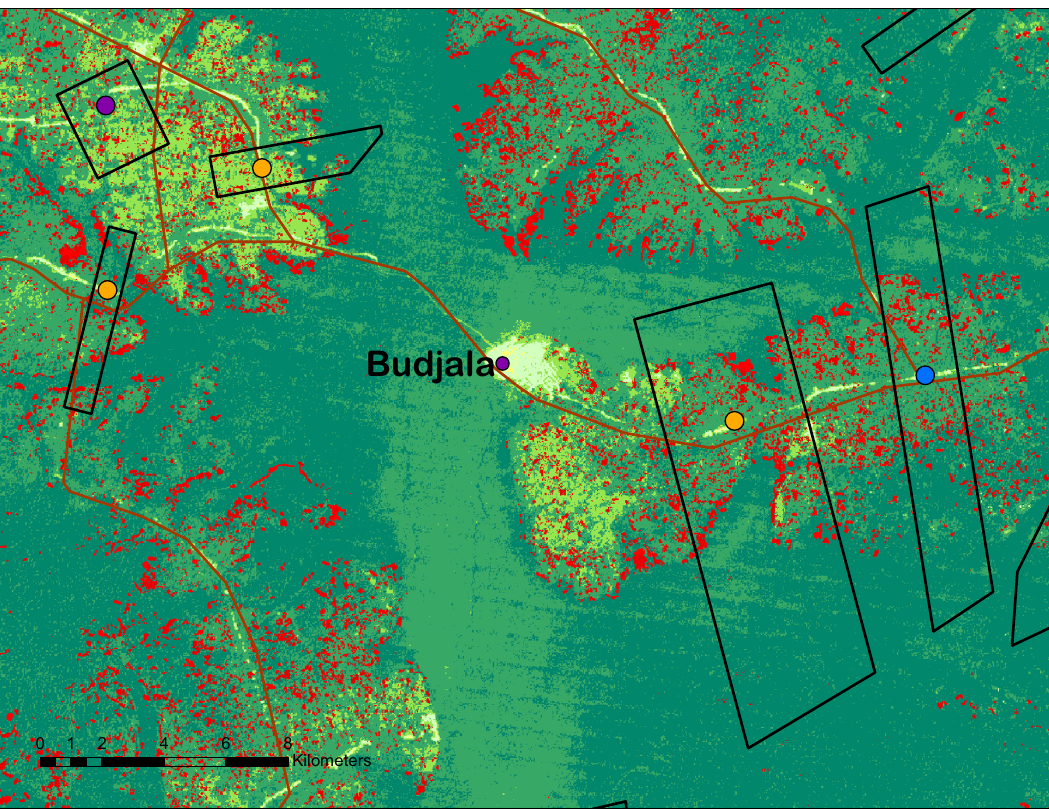
Fig. 6 | Map offorest coverand forest cover loss atthe village level. Note: Close-up ofanexampleof village shapes based on village surveys.The darkgreen areasare those with a canopy tree cover greater than 90%. The cells marked in red are those deforested between 2013 and 2016, as per the Hansen